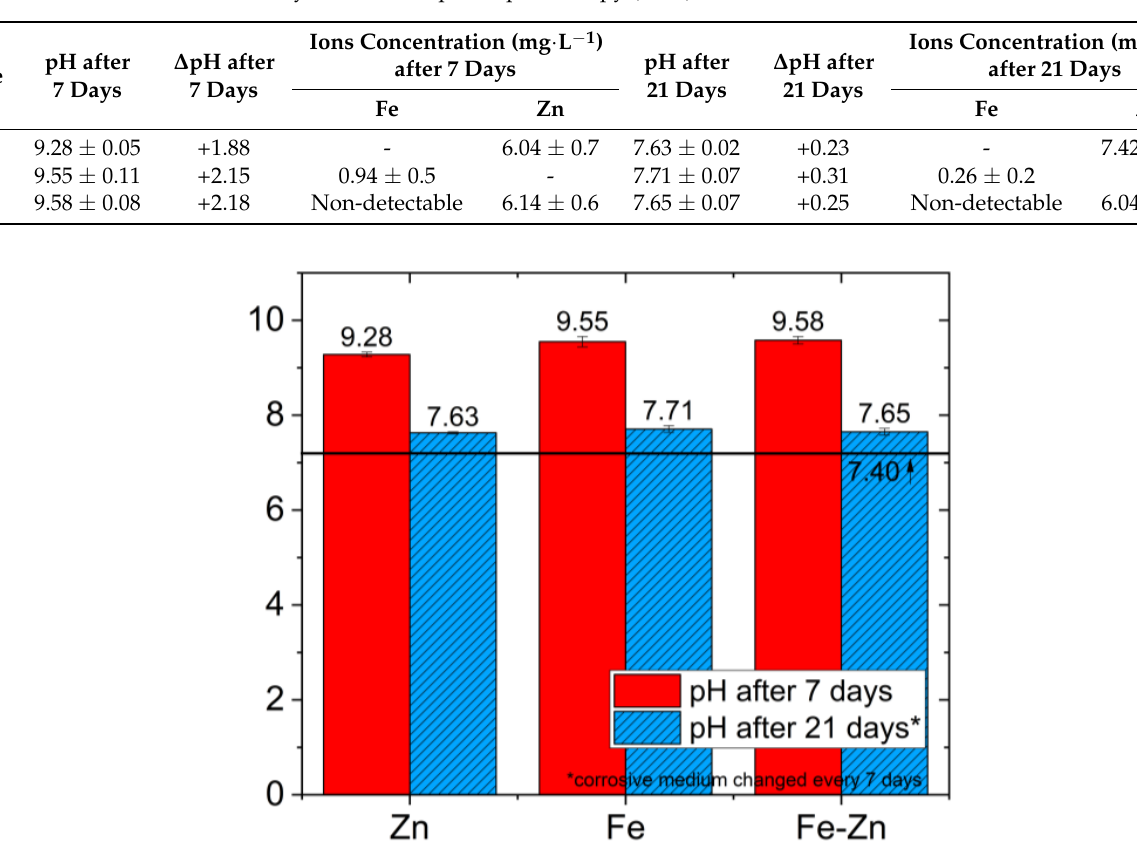
Figure 8. Optical photographs of corroded Zn ( a , d , g ), Fe ( b , e , h ) and Fe-Zn ( c , f , i ) samples after 21 days of immersion in simulated body fluids (Hanks´ solution at 37 ± 2 °C, pH = 7.4 ± 0.2). 4. Discussion Three different types of metallic samples were prepared from raw powders, and their degradation properties were studied. Initial Fe, Zn and Fe-Zn powders were studied us- ing SEM and EDX methods. A difference in the starting powders was detected. While the Fe powder tends to create aggregates due to its magnetic character, zinc powder particles were homogenously distributed without the signs of aggregation. Aggregation was sup- pressed in the Fe-Zn mixture due to the zinc presence. EDX analysis revealed that the